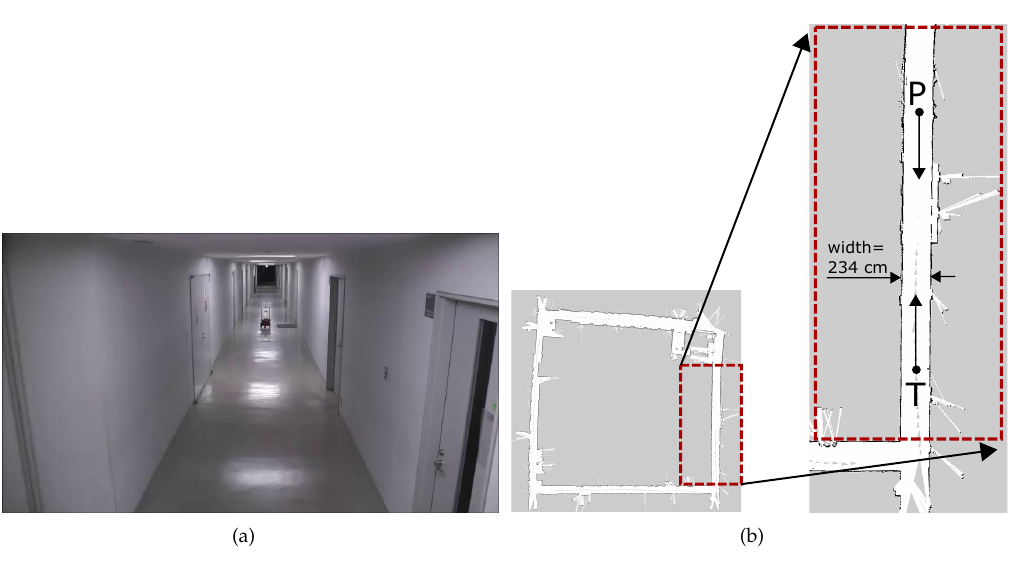
Figure 16. Experiment setup. ( a ) corridor scenario used in experiments; ( b ) grid-map of the environment. The zoomed out section shows the width of the corridor. Starting locations and directions of movement of the two robots are also